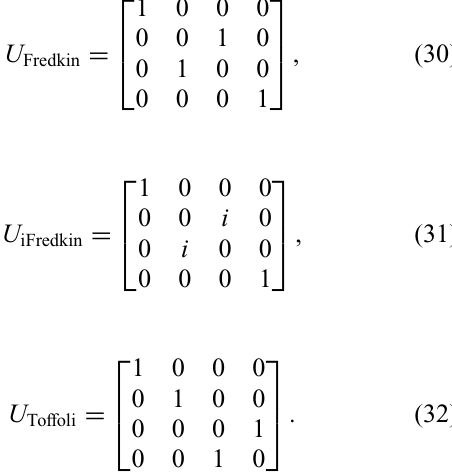
middle diagonal elements in U will have opposite signs, which does not match the CCZ gate acting on qubits 0 and